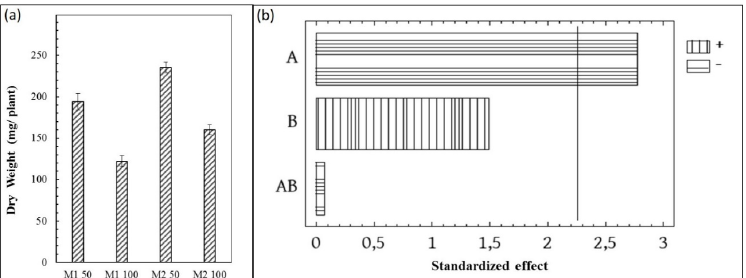
Figure 2. Effect of substrate mixture and fertilization on fresh weight. ( a ) relation between dry weight and substrate (M1 or M2) and fertilizer concentration (50 or 100); ( b ) Pareto graph of the fresh weight of coriander plants. A: Factor A (fertilizer concentration) effect; B: Factor B (Substrate mix) effect; AB: Effect of factor interaction.